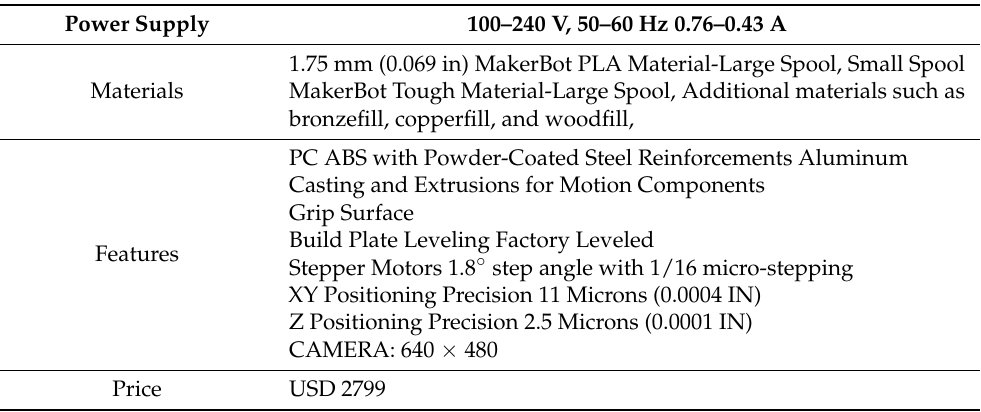
Table 8. Descriptions of Makerbot Replicator+ Desktop 3D